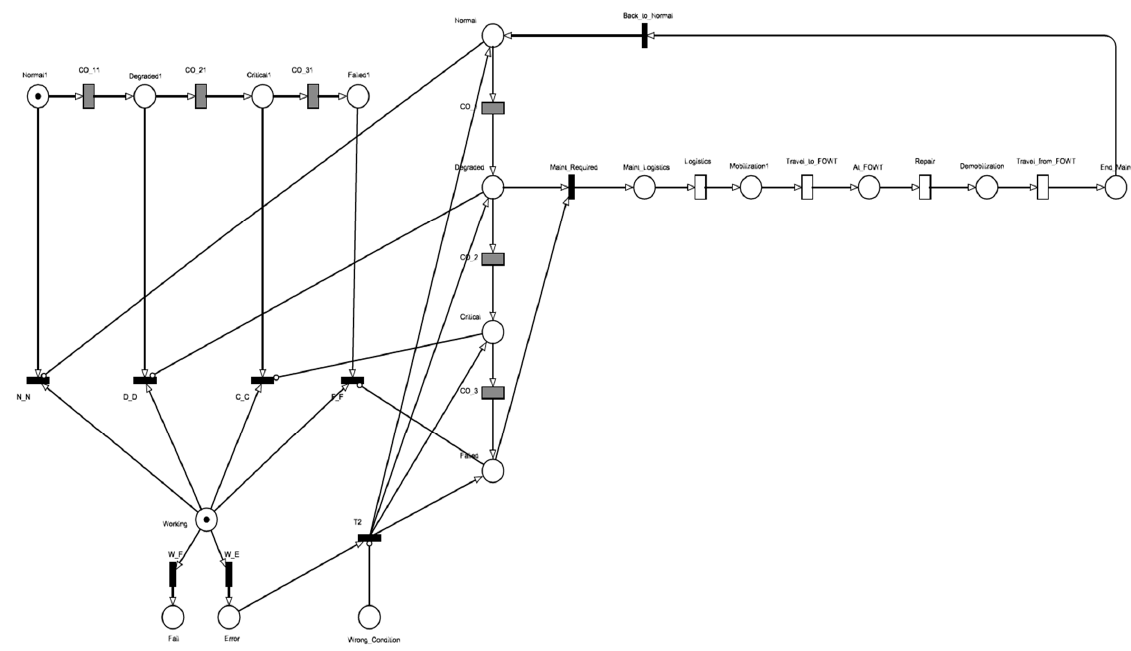
Figure 6. TimeNET model of component degradation and maintenance process for FOWTs. Table 3. Types of maintenance for wind turbines